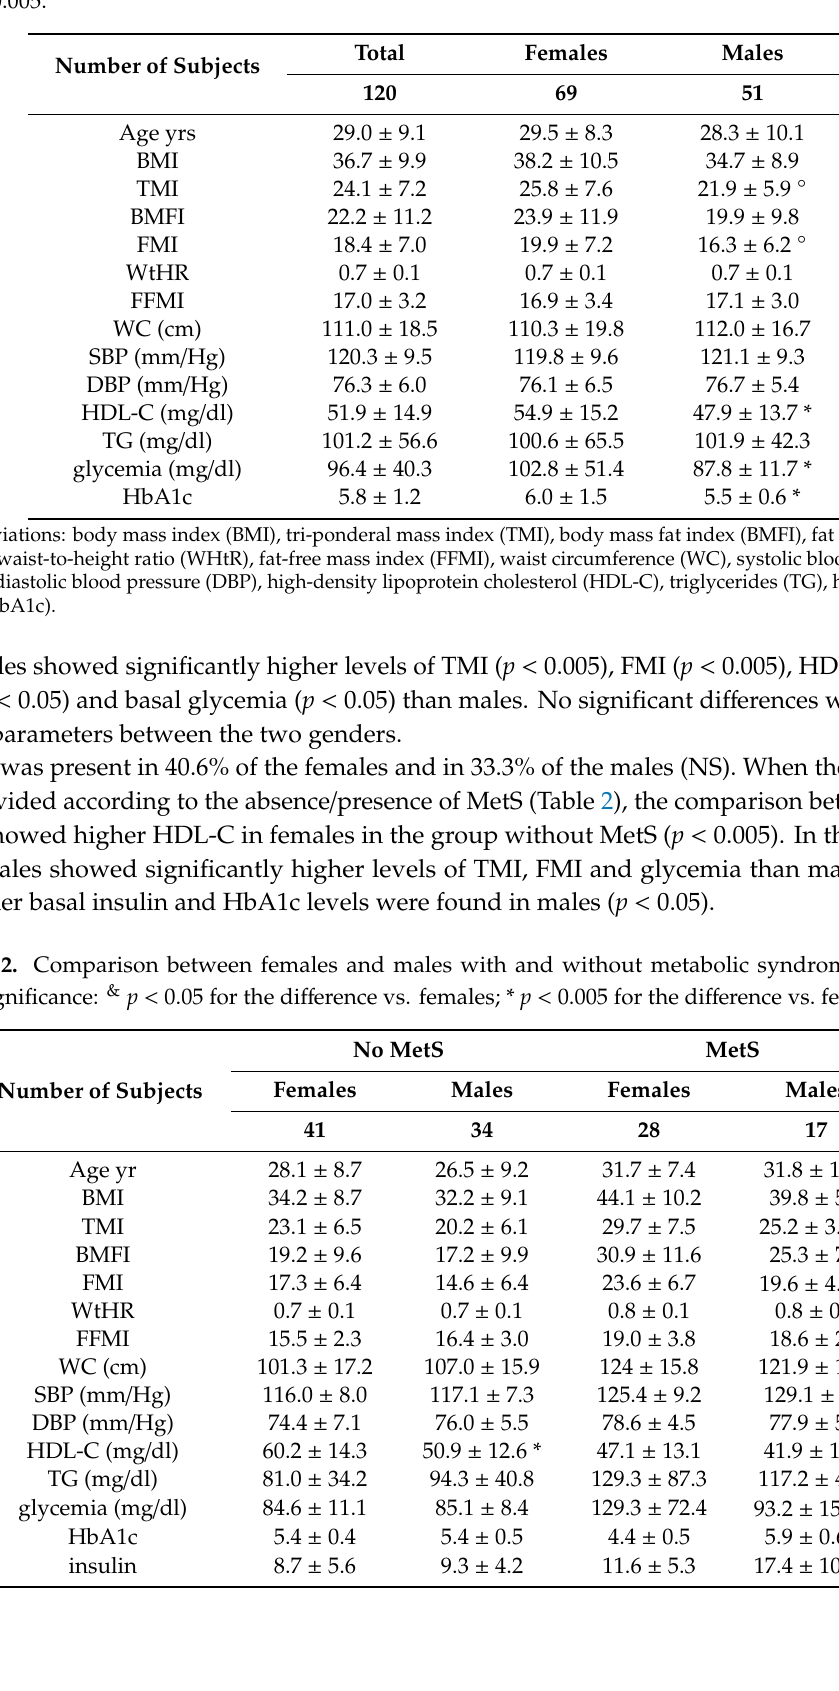
Table 1. Clinical findings of Prader-Willi syndrome (PWS) patients. For significance: * p < 0.05; ◦ p < 0.005.